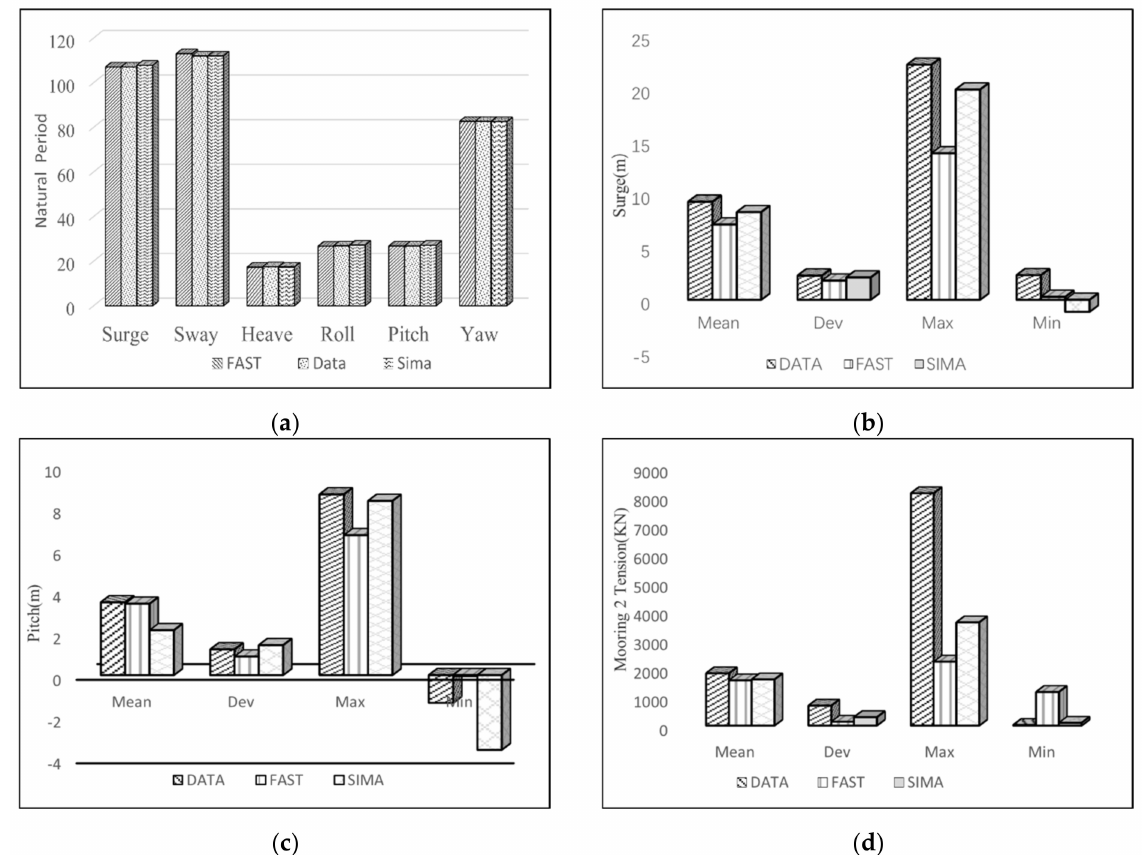
Figure 3. Comparison diagram of SIMA simulation results under combined action of wind and wave ne. ( a ) Natural periods comparison. ( b ) Surge motion response comparison. ( c ) Pitch motion response comparison. ( d ) Comparison of No. 2 mooring line tension